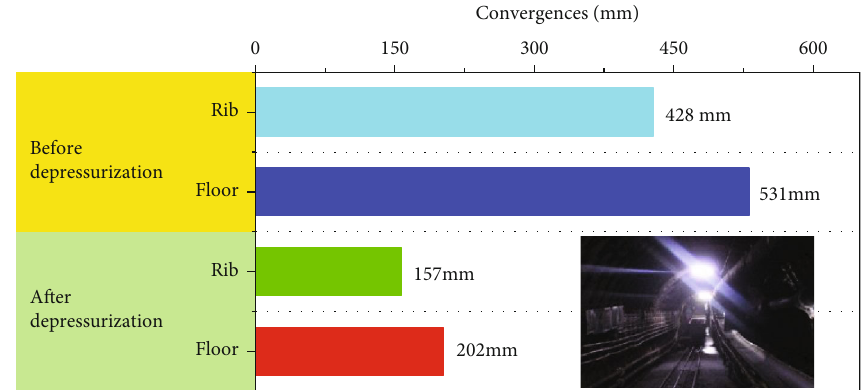
Figure 11: Comparison of the roadway deformation before and after depressurization. The photograph at the lower-right corner shows the roadway maintenance with drilling depressurizing